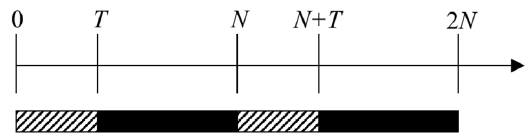
Figure 2. The sliding window recognition scheme based on polynomial fitting.